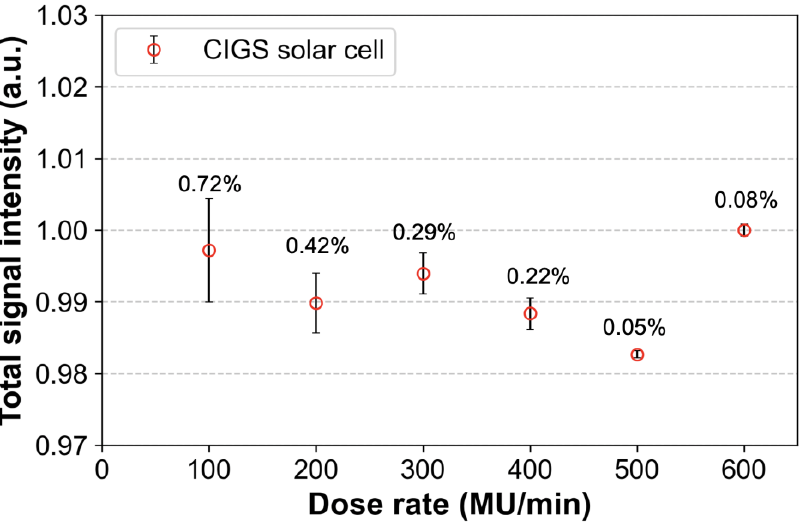
Figure 5. The signals obtained from the copper indium gallium selenide (CIGS) solar cell according to changes in dose rate from 100 to 600 MU/min at intervals of 100 MU/min. Total signal intensity is the sum of the obtained signals from the CIGS solar cell during irradiation. All the signals were normalized based on the signal corresponding to a dose rate of 600 MU/min. Error bars denote the standard deviations (numbers above the error bars) between three repeated measurements.